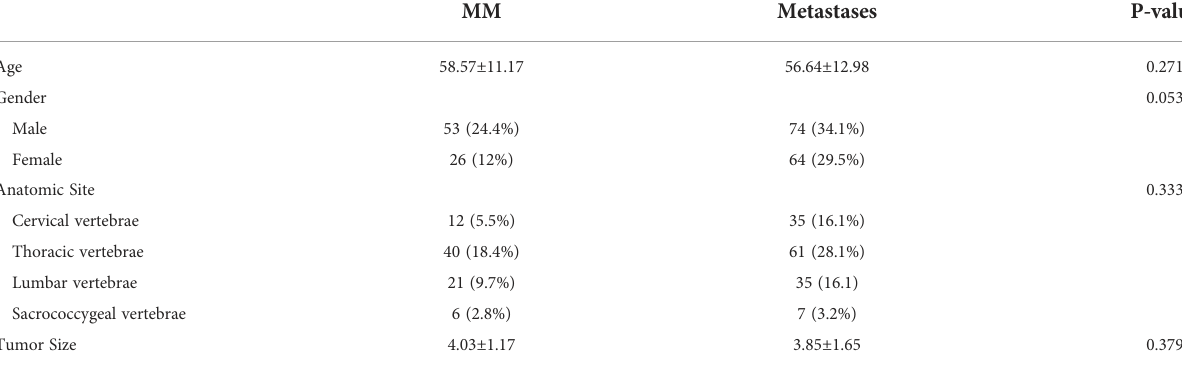
TABLE 1 Basic clinical information for patients with spinal MM and metastases from lung